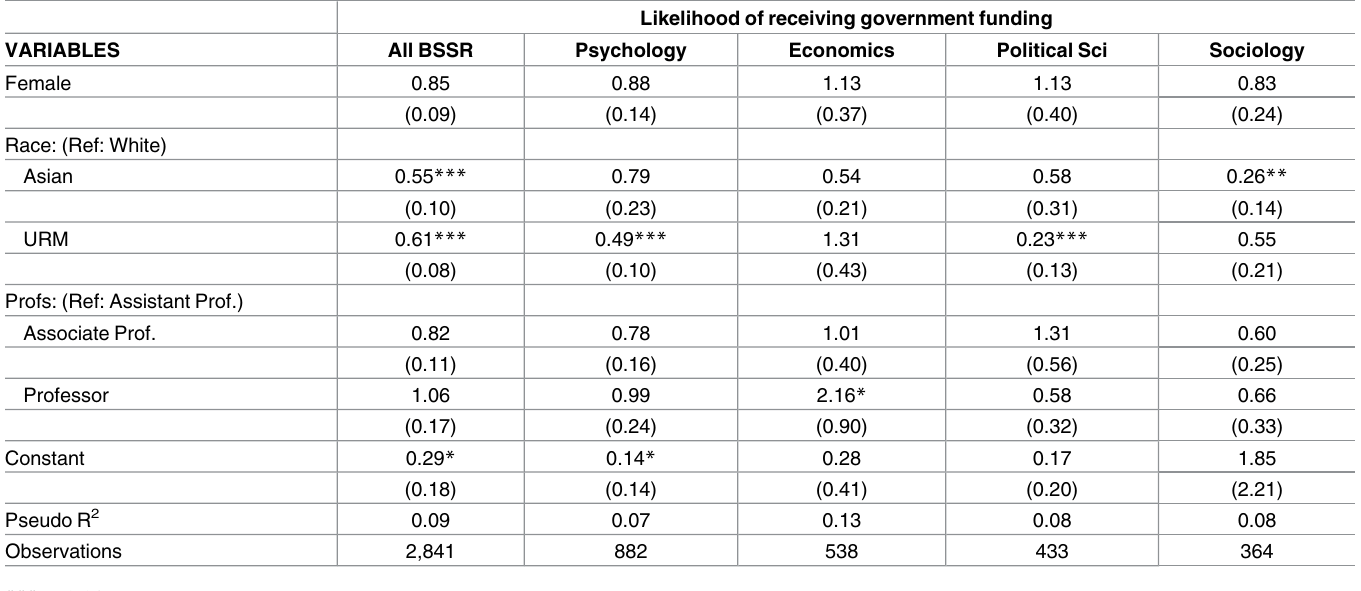
Table 6. Associations between demographic variables and the likelihood of receiving government funding among BSSR scientists employed in tenure-track or tenured